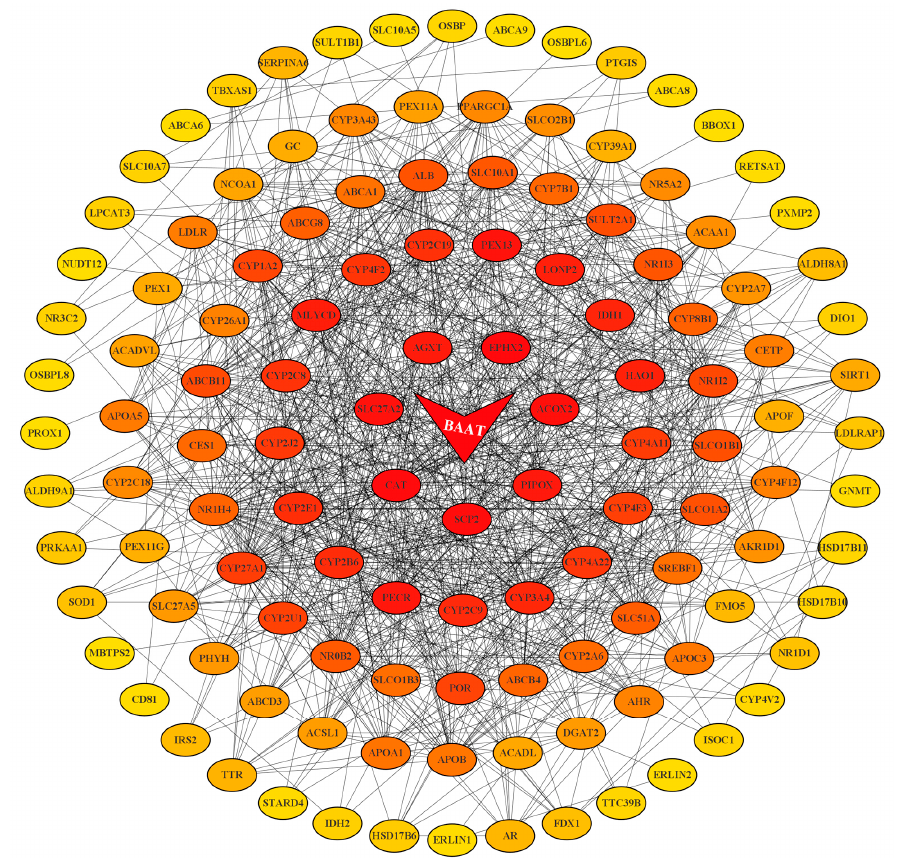
Figure 6. PPI network construction for 125 enriched genes using Cytoscape. The lines in the network diagram represent the connectivity of each gene, and the color represents their scores, with darker nodes representing higher scores and higher rankings. BAAT is the top-ranked most critical node gene based on the MCC algorithm, located in the center of the network diagram. BAAT is the final modification before catalyzing the generation of conjugated BAs from free BAs into the enterohepatic circulation [19]. Evidence indicates that BAAT promotes gly- cine-conjugating BAs with extremely low efficiency but efficient conjugating with taurine in rats [20,21]. The TCGA database supports that BAAT is significantly under-expressed in HCC cases (** p < 0.01, Figure S2), suggesting that BAAT deficiency is partly responsible for the decrease in taurine-conjugated BAs in the intestine, which would alter the composition of the intestinal bile acid pool and increase its toxicity, thereby promoting the progression of inflammation to HCC. 3. Discussion